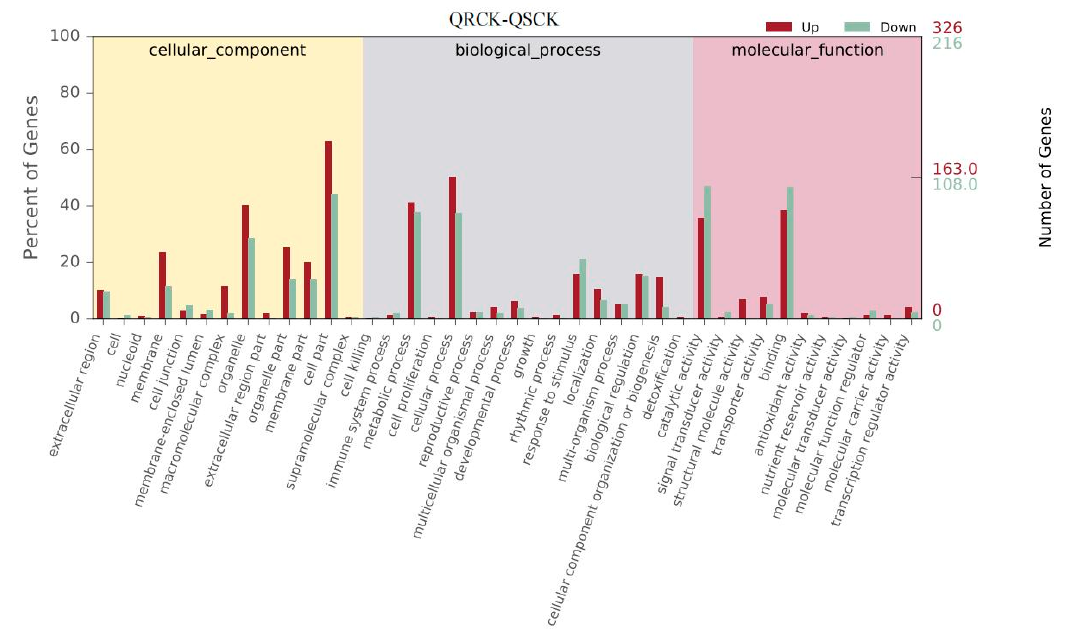
Figure 6. Gene Ontology (GO) analysis of the DEGs between two E. crus-galli populations. GO analysis was performed at level 2 for the three main categories.